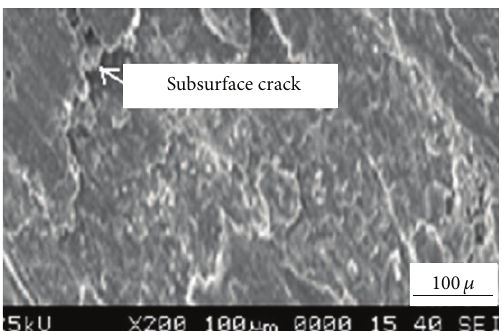
Figure 10: SEM micrograph of the worn surface of the Al alloy at a normal load of 49 N with 2m/s sliding velocity.